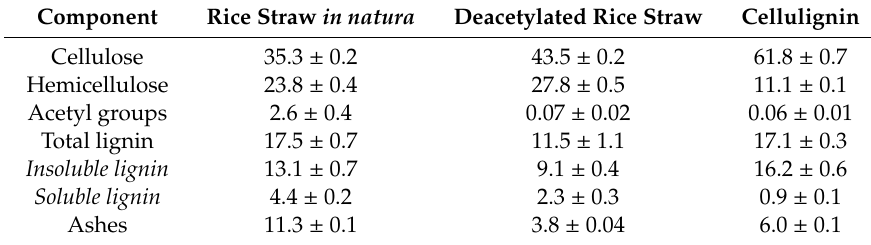
Table 1. Composition (g / 100 g, dry matter) of the original ( in natura ) and pre-treated rice straw used in this